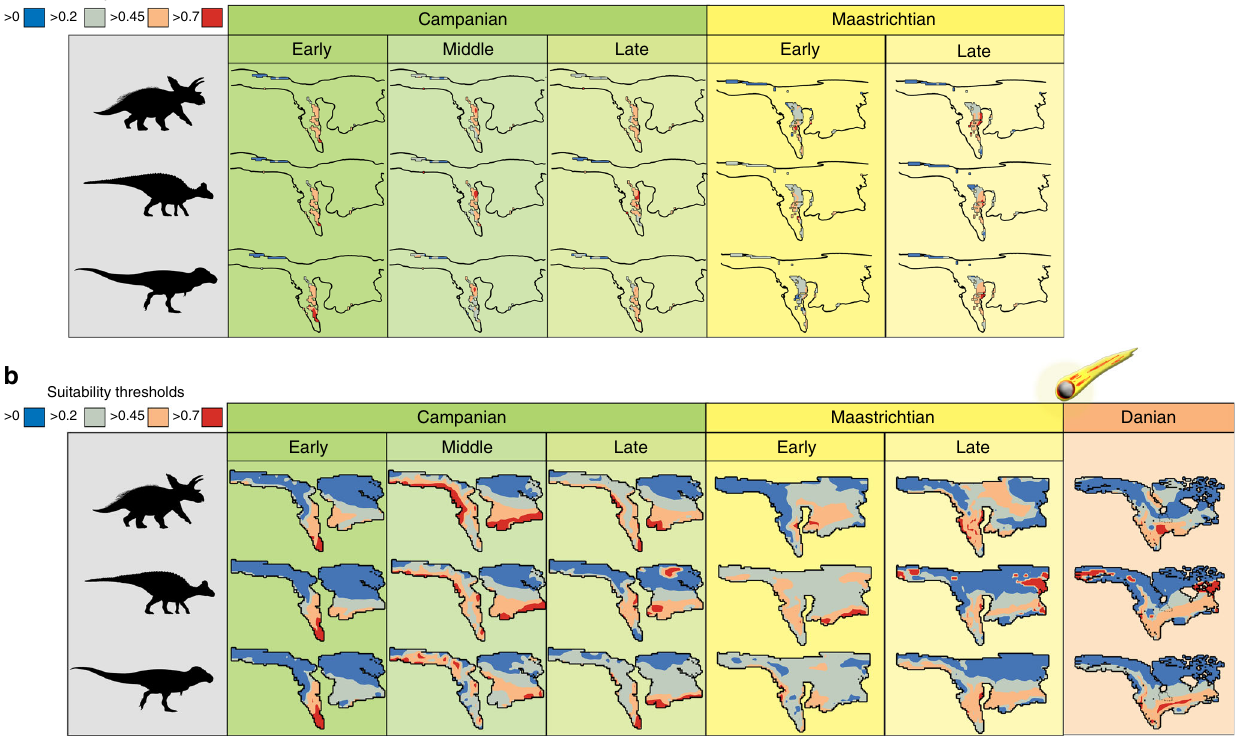
Fig. 3 Ecological niche models for the three major clades of non-avian dinosaurs in the latest Cretaceous of North America. From top to bottom: Ceratopsidae, Hadrosauridae, and Tyrannosauridae. Niche dynamics in outcrop areas ( a ) show a progressive decrease of high-suitability areas (orange and red) towards the Maastrichtian compared to unsuitable areas (blue) while overall niche stability or increase is shown in a continental setting ( b ). Tyrannosauridae silhouette by Jack Mayer Wood (CC BY 3.0 license: https://creativecommons.org/licenses/by/3.0/ CC BY 3.0); Hadrosauridae silhouette by Pete Buchholz (under CC BY-SA 3.0 license: https://creativecommons.org/licenses/by-sa/3.0/); and Ceratopsidae silhouette by Mariana Ruiz (modi fi ed by T. Michael Keesey) under the Public Domain Mark